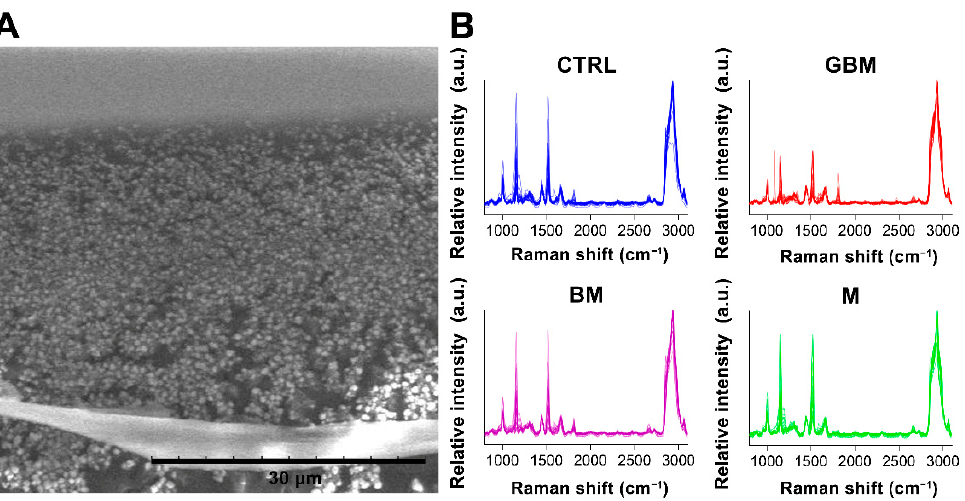
Figure 3. Particles on a calcium fluoride substrate (scanning electron microscope image) ( A ). Aver- aged and SNV-normalized spectra of the four patient groups ( B ). (Abbreviations: a.u., arbitrary unit). Following SNV-normalization, the spectra for the samples of the four patient groups were compared pairwise (each patient group was compared to the control, and BM vs. GBM